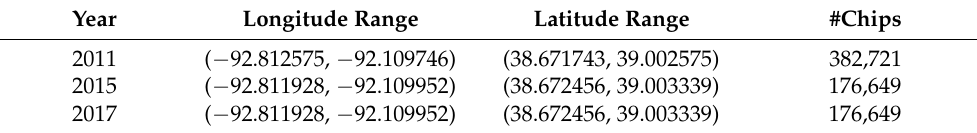
Table 3. Intersected dataset